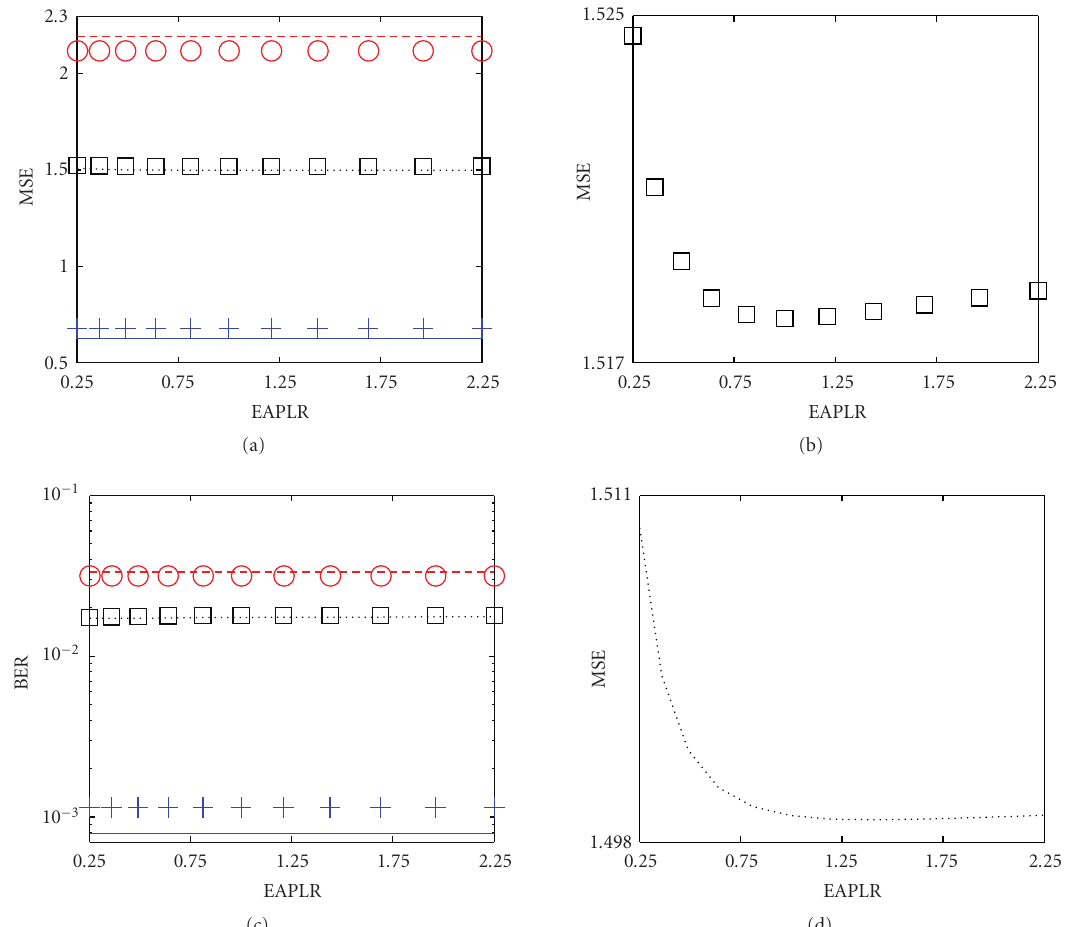
Figure 10: MSE and BER as functions of the estimated-to-actual-path loss ratio (EAPLR) under the per-antenna and per-cell power 3 + 10dB, averaging over 20 channel realizations). ( Legends are the same as in Figure 5. ) constraints (10log tP = 10log 10 10 − 2 β errors of path loss (PL = αd in (4a)) is ic